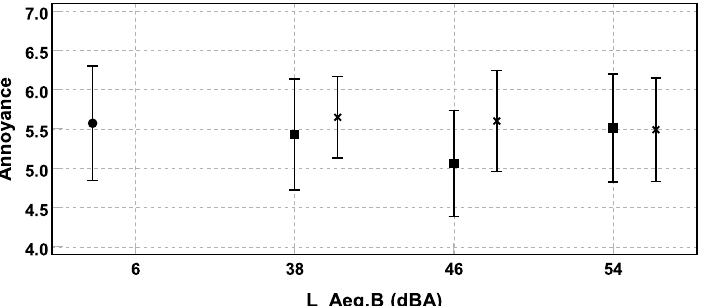
Figure 8. Interaction (experiment 2) background type and L Aeq,B : mean acoustic comfort ratings across subjects and their 95% confidence intervals are depicted. Circle ( for no, less eventful, and eventful background, respectively. Note that only the annoyance range from 4–7 is shown here, although the scale ranged between 0 to